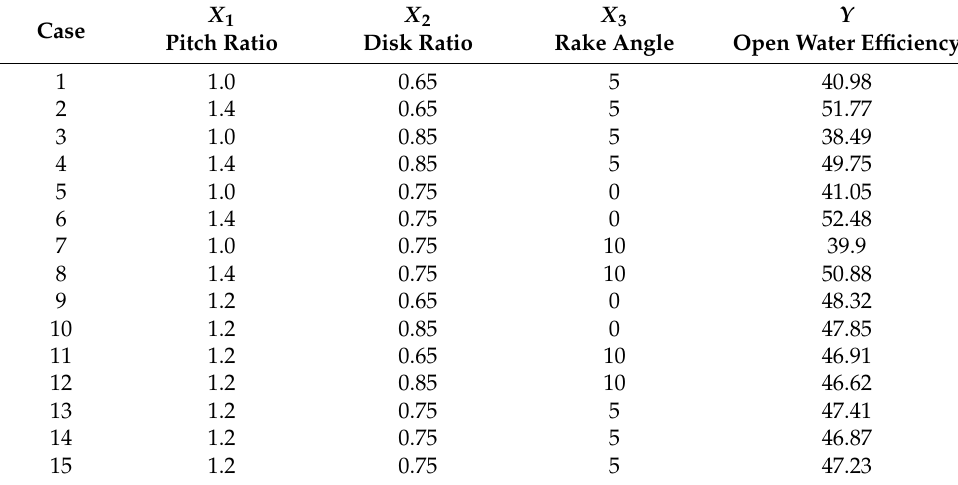
Table 7. Experimental